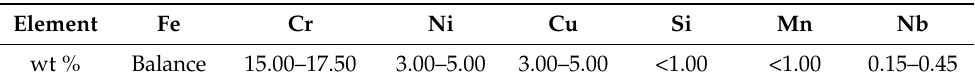
Table 2. Composition of 17-4 PH stainless steel (3D Systems Company, Rock Hill, South Carolina, USA). Element